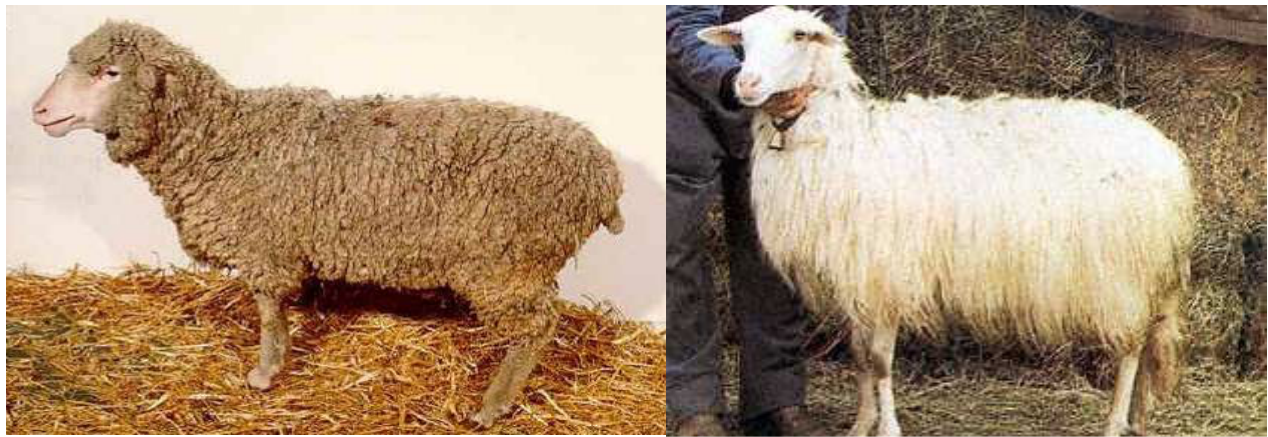
Figure 3. The two breeds analyzed: Gentile di Puglia (left) and Sarda